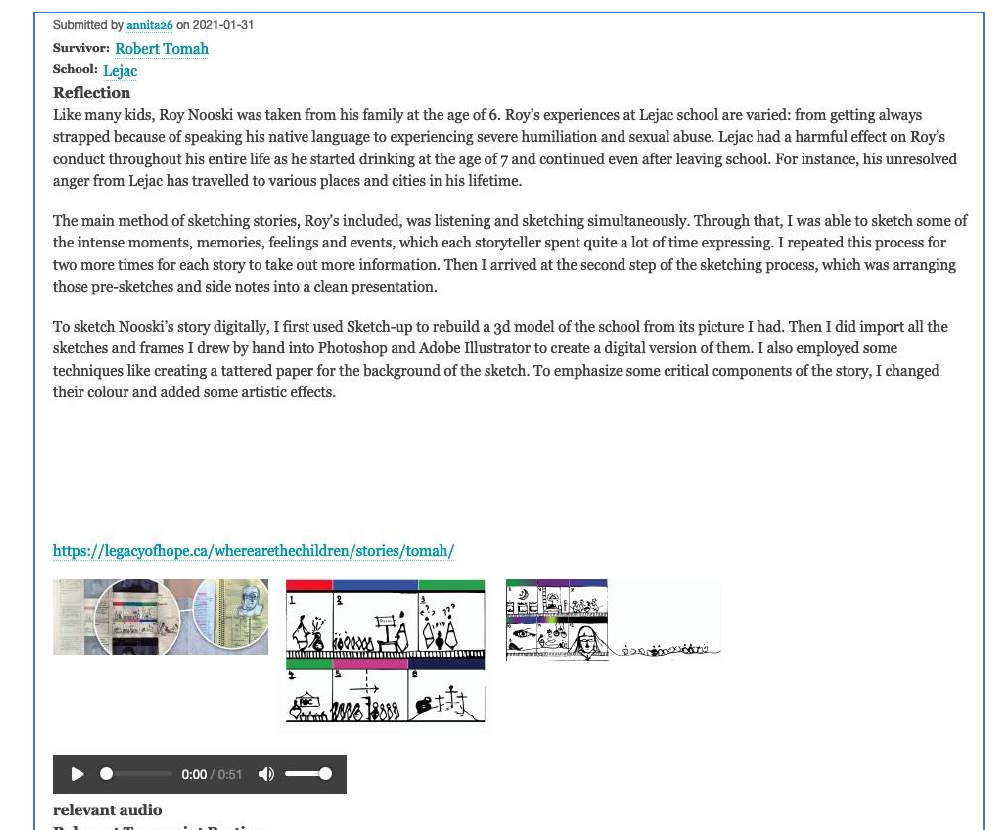
Figure 9. Screenshot of the Mapping Survivor Stories Map home page showing a thumbnail pop-up for Robert’s memory of flying from home to begin attendance at Lejac Residential School.